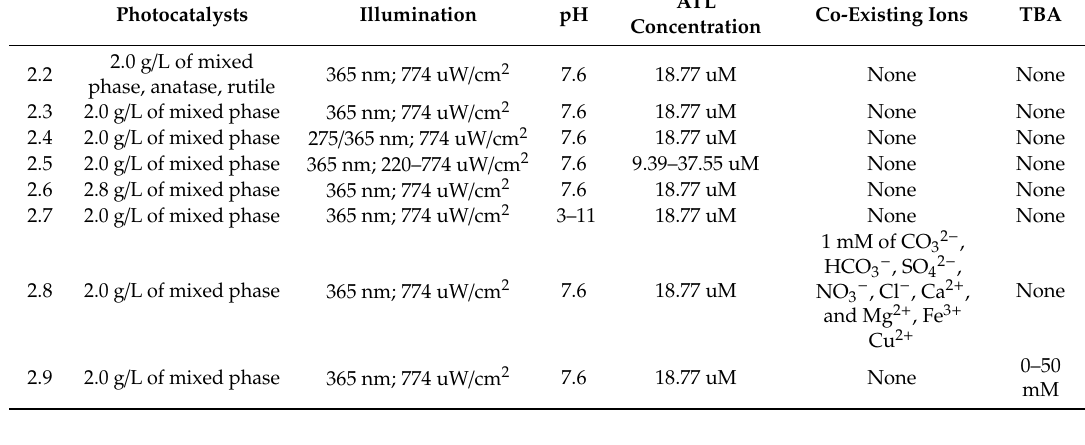
Table 4. Di ff erent experimental variables regarding atenolol photodegradation with TiO 2 photocatalyst under UV-LED.